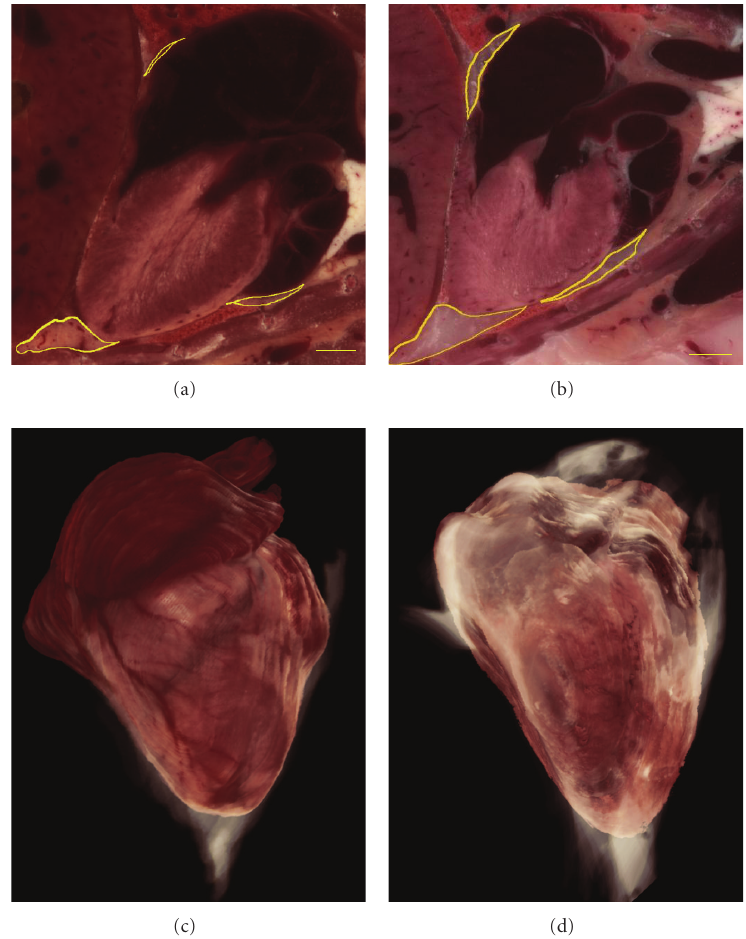
Figure 6: Pericardial adipose tissue. The PEPCK-C mus mouse has less pericardial adipose tissue (a) compared to the control animal (b) as shown in the yellow outlines on the coronal section images. From the 2D images the heart was reconstructed in 3D with the pericardial fat rendered in white for PEPCK-C mus (c) and control mouse (d). The rendering for fat was done in lower transparency so that the heart can be seen through it. Pericardial fat is considered an ageing biomarker. Note in (c) that the coronary vessels are clearly seen on the 3D surface of the heart (Bar =